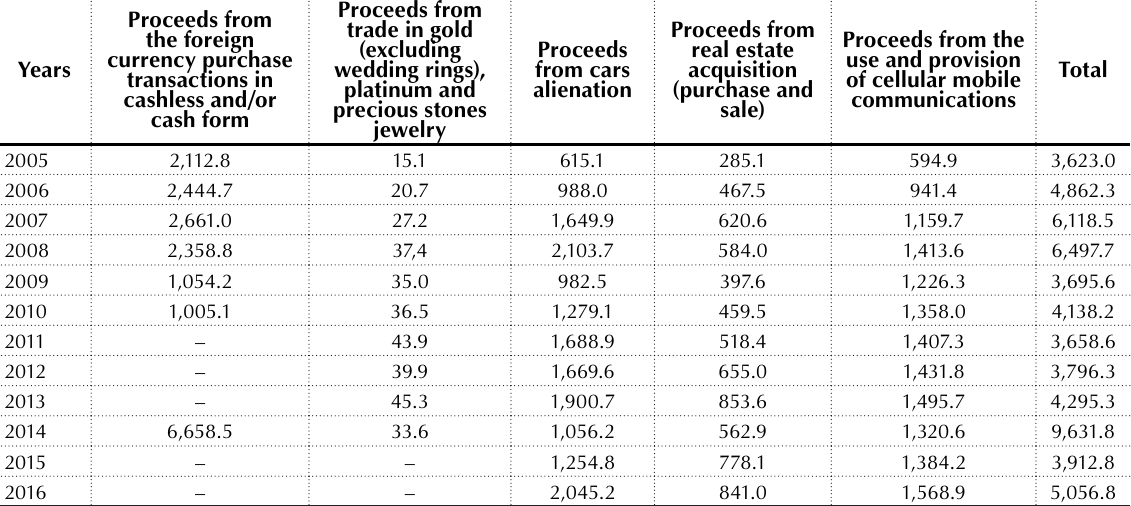
Table 2. The dynamics of fund flows to the state budget of Ukraine to be transferred to the Pension Fund of Ukraine in 2005–2016, UAH